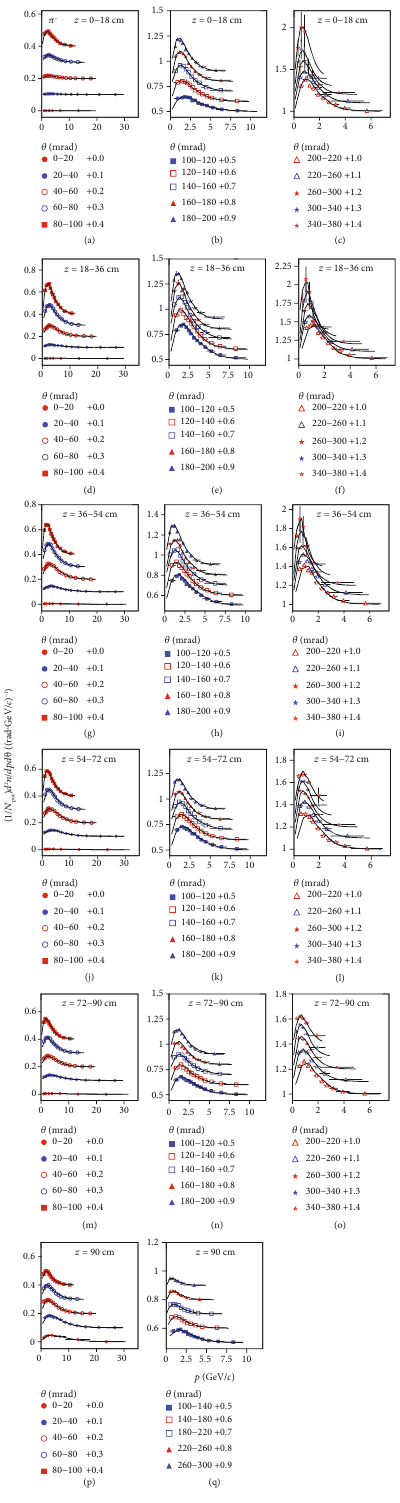
Figure 2: Same as Figure 1 but showing the spectra of π −